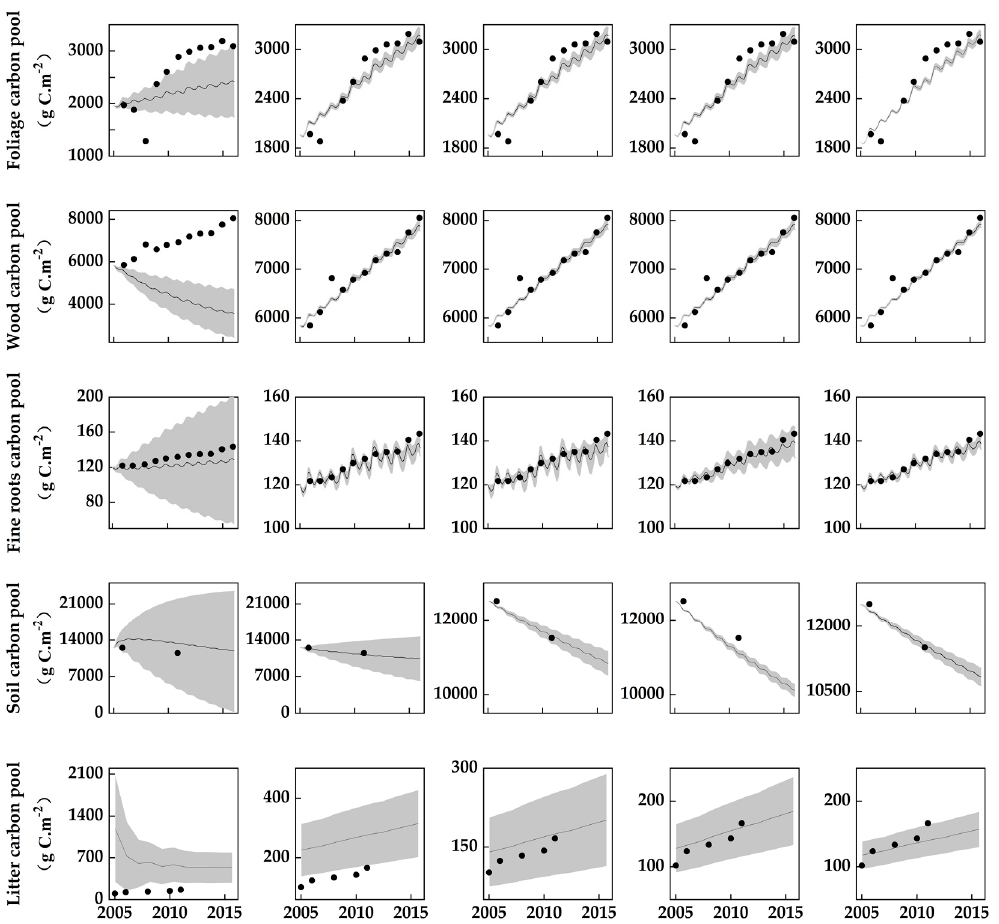
Figure 3. Comparison between modeled and observed values of carbon pools (Run 1 to 5 from left to right (Table 1). The solid line in the figure represents the average value of modeled results, the gray area represents the 95% confidence interval, and the blank circle represents the observed value). Table 3. Fit between the modeled and observed values for six variables at the Huitong subtropical Chinese fir plantation.